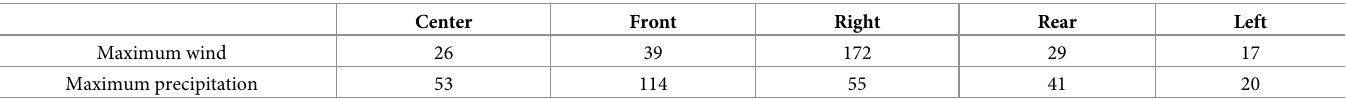
Table 1. The occurrence numbers of maximum wind and rainfall in the center region, and four quadrants (front, right, rear, and left) out of the center region. The center region is defined as the region within 100 km from the TC center. The direction of four quadrants are based on the direction of TC